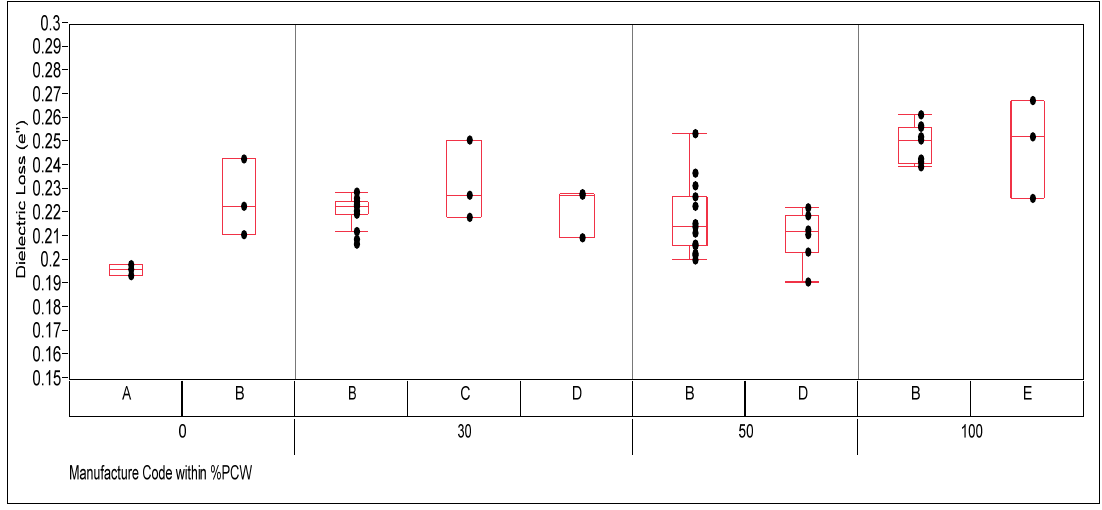
Figure 4. Company-to-company variability in dielectric loss, a for various—percent PCW content in commercial white copier papers, due to manufacturing process and additives.